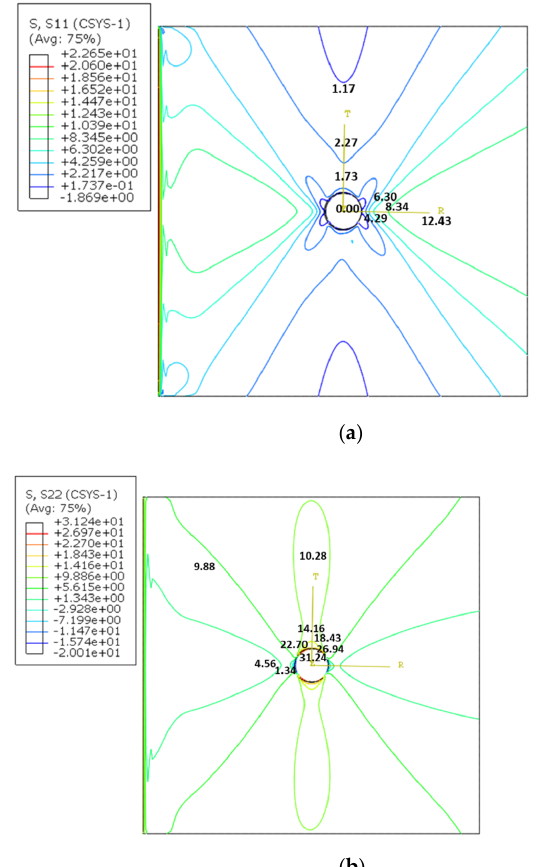
Figure 11. Stress contour distribution in the braided plate under uniform tension ( a ) Radial and ( b ) circumferential.